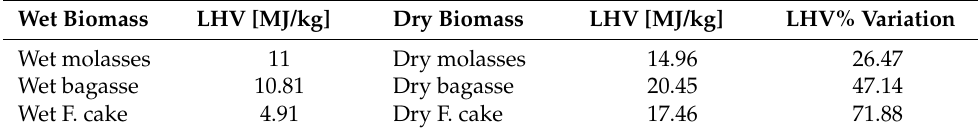
Table 3. Impact of moisture content in calorific value of biomass conversion.